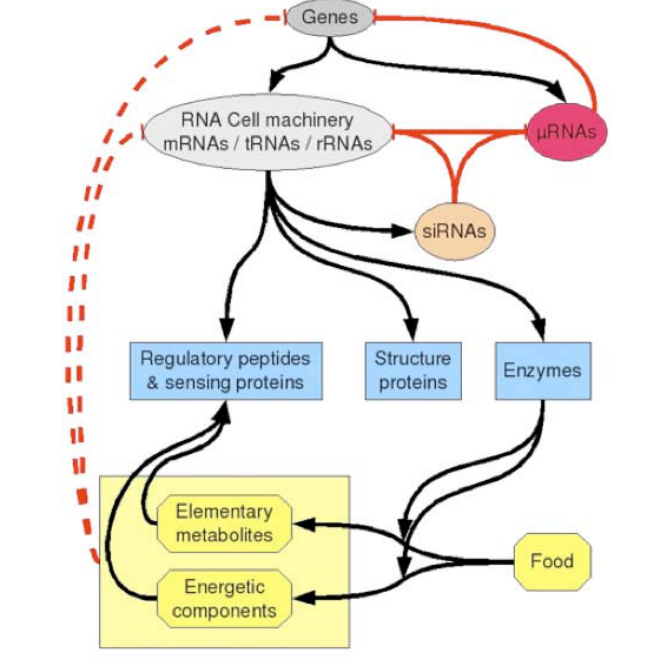
Figure 9. Schematic view of regulatory processes that can occur in a cell. Positive and negative classical regulations as well as syntheses are shown as black arrows. Negative regulations due to miRs and siRNAs are indicated as red arrows. A possible contextual down-regulation (dashed red lines) could come from direct interaction between metabolites (amino-acids and their derivatives, or energetic nucleotides) and RNA or DNA